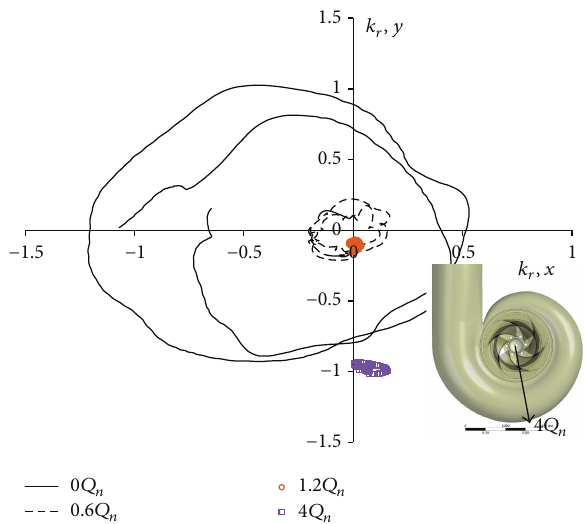
Figure 12: Components of radial thrust in PAT mode.